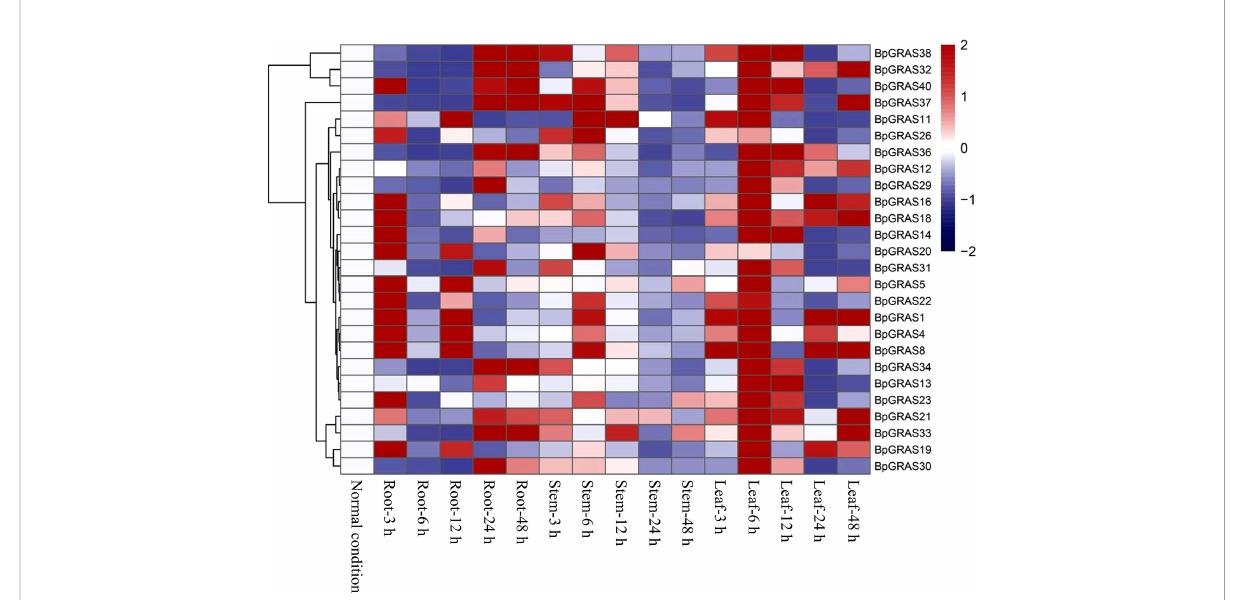
FIGURE 5 Heat map of the expression pro fi les of 26 BpGRASs . Heat map of the expression pro fi les of all BpGRASs in different birch tissues at different time points under 200 mM NaCl stress treatment. The color scale represents the log2-transformed gene relative expression compared to that observed under normal conditions (0 h): blue to red colors denote the low to high level of relative expression.